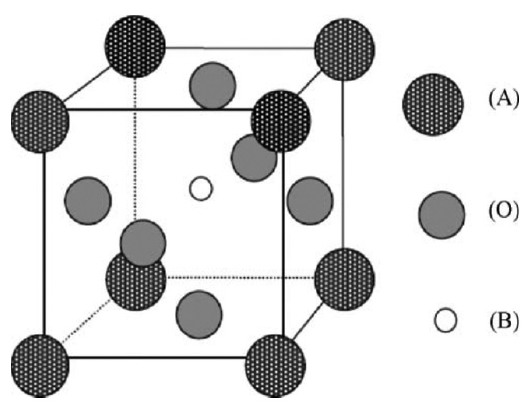
Figure 2. General structure of perovskite 1